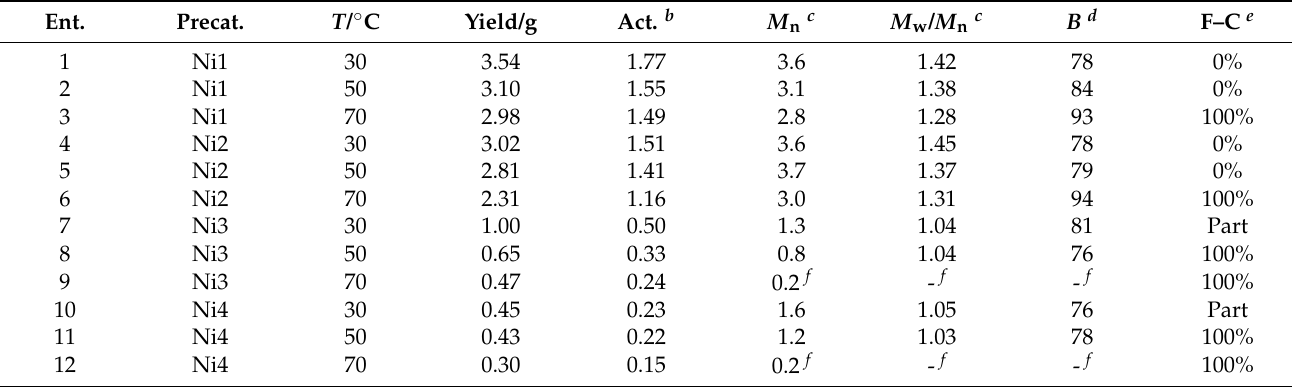
a General conditions: complexes (2 µ mol), Et 2 AlCl (200 equiv.), 1 mL CH 2 Cl 2 , 20 mL toluene, time = 1.0 h, ethylene = 6 atm. b Activity (Act.) = 10 6 g/(mol Ni · h). c Molecular weights (kg mol − 1 ) determined by GPC